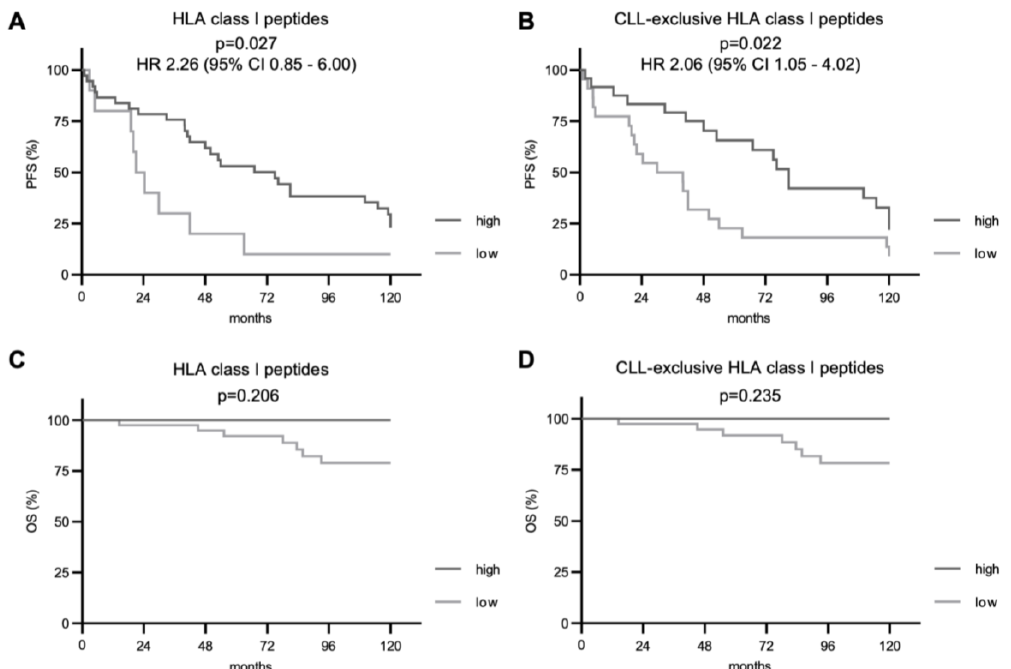
Figure 3. Impact of total and CLL-exclusive HLA class I peptide presentation on clinical outcome. Impact of total and CLL-exclusive HLA class I peptide presentation on PFS ( A , B ) and OS ( C , D ). Kaplan – Meier analysis, log-rank test. Abbreviations: HR, hazard ratio; CI, confidence interval; p , p -value.